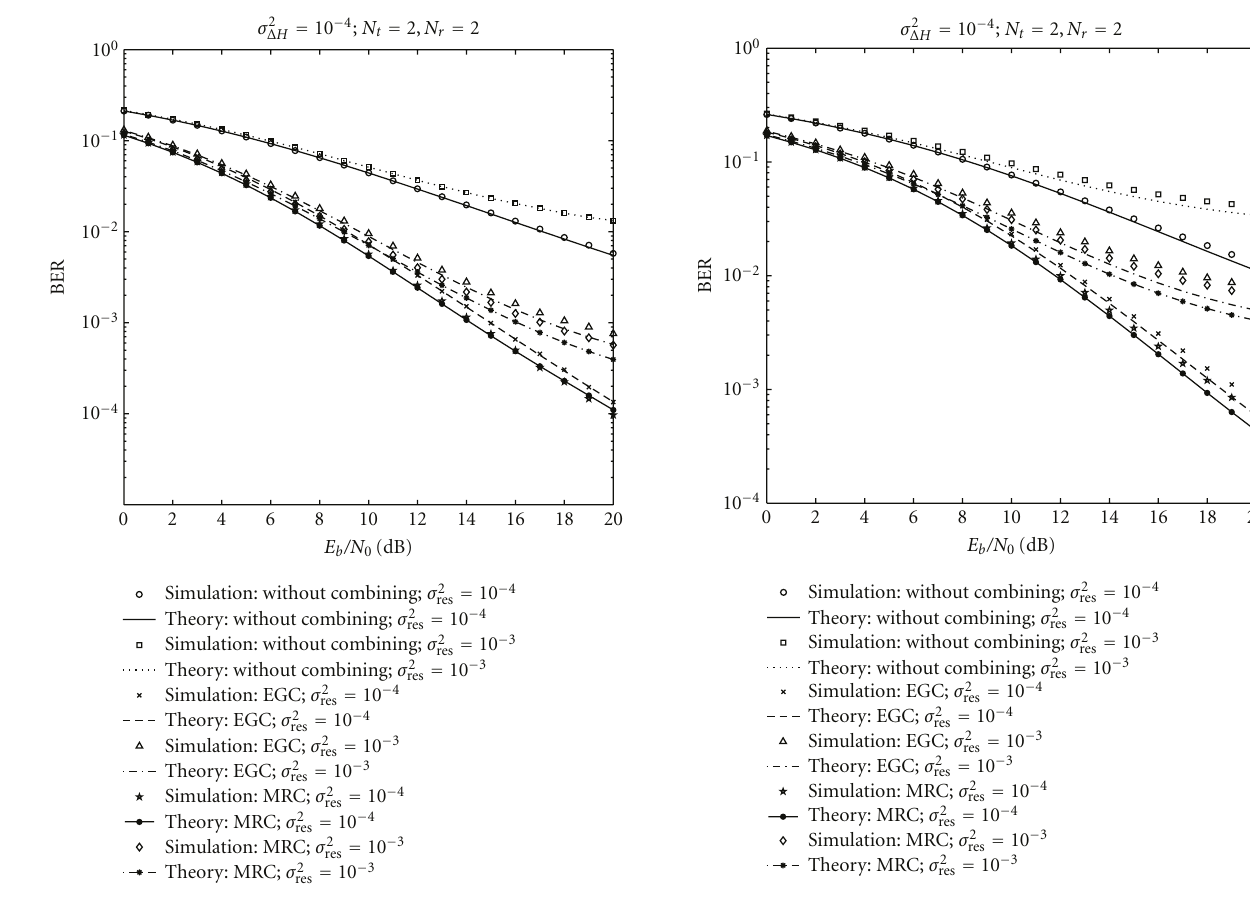
Figure 6: BER with QPSK when ( N t = 2, N r = 2). Figure 7: BER with 16QAM when ( N t